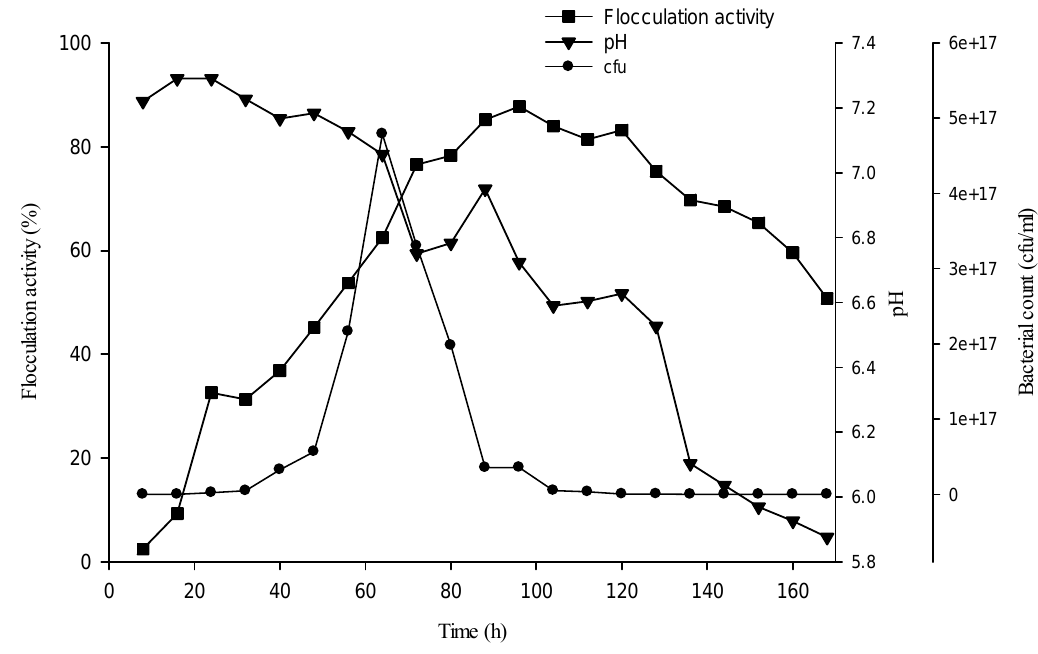
Figure 3. Bioflocculant production time course of Brachybacterium sp. UFH using optimum fermentation conditions and nutritional